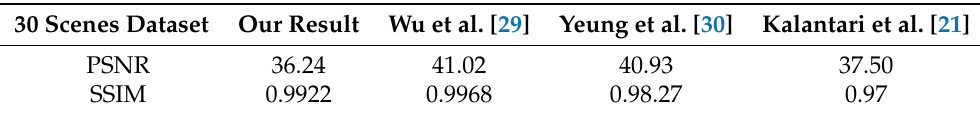
Table 7. Comparison with Wu et al. [29], Yeung et al. [30] and Kalantari et al. [21] for the 30- scenes